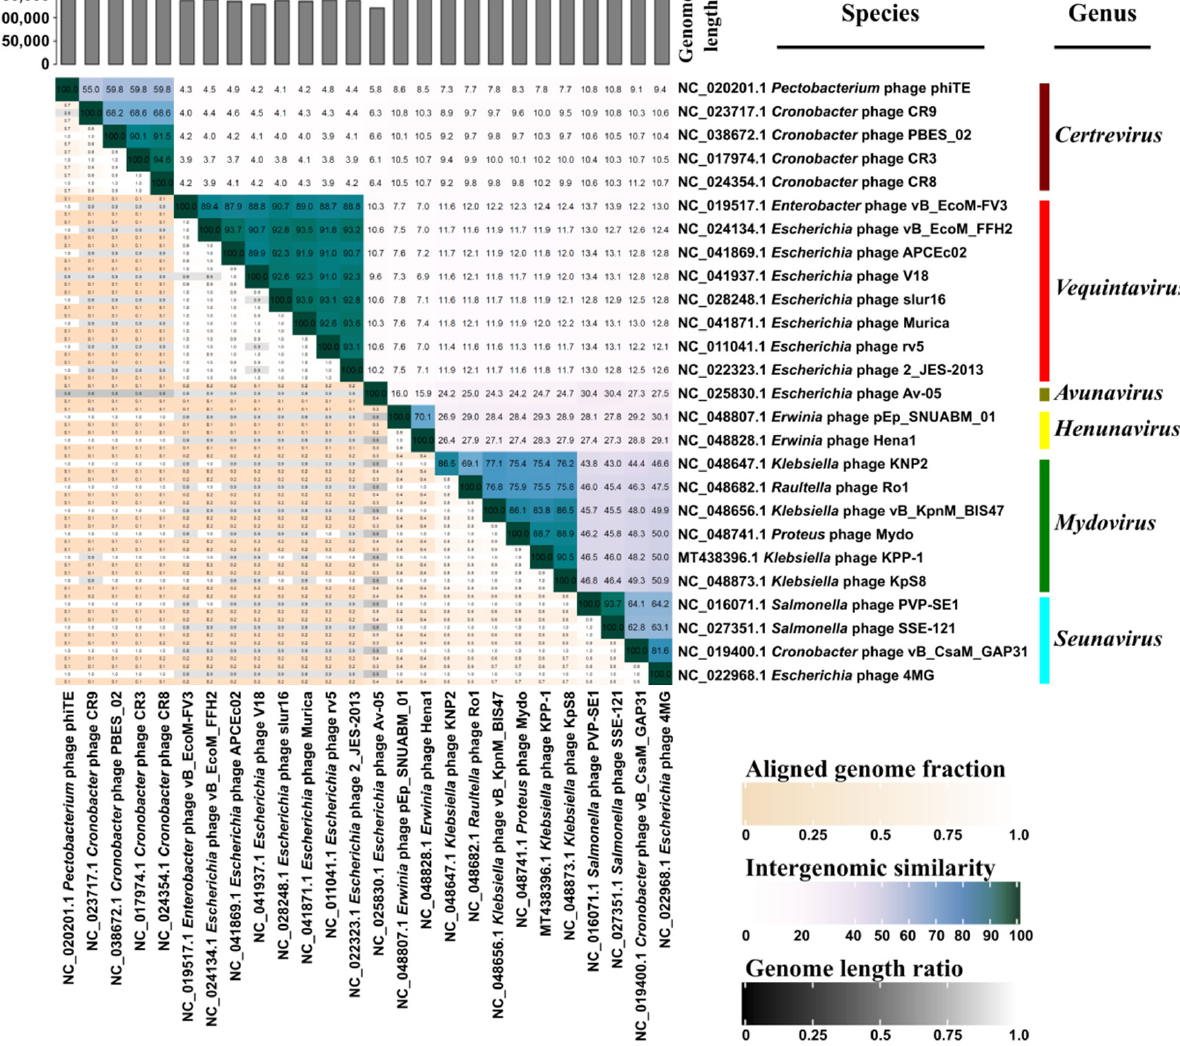
Figure 2. VIRIDIC analysis. Twenty six bacteriophage genomes (ICTV classified) belonging to subfamily Vequintavirinae were compared. The diagram provides information about aligned genome fraction, intergenomic similarity, and genome length ratio of selected genomes compared to each other. The genus-level classification was also